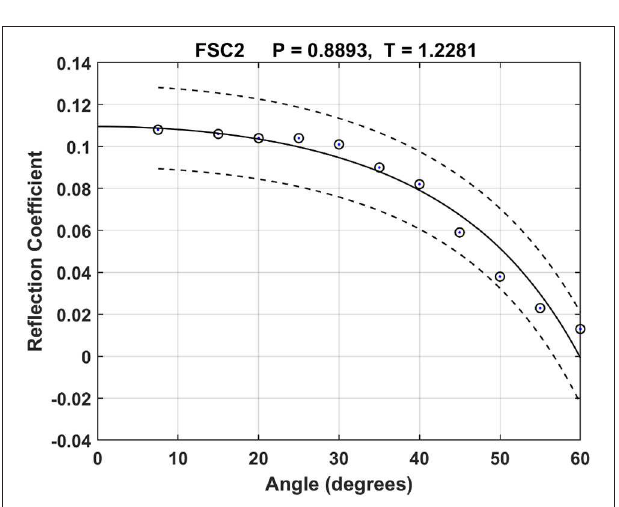
FIGURE 9 | Results of a nonlinear least squares fit of theoretical Equation (2) to the FSC2 snow sample reflection data. The best fit (solid line) is obtained for a porosity of 0.89 and a tortuosity of 1.23. Confidence intervals are shown as dashed